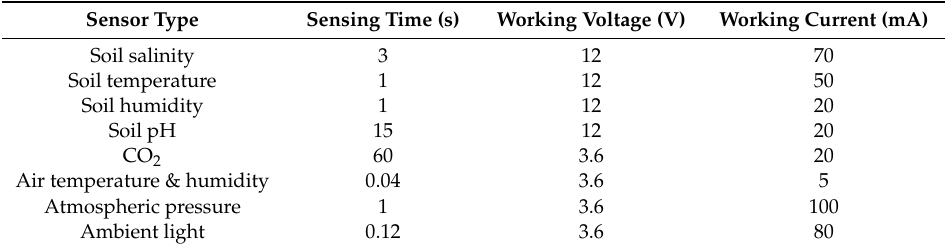
Table 2. Sensing time and energy consumption of sensors.